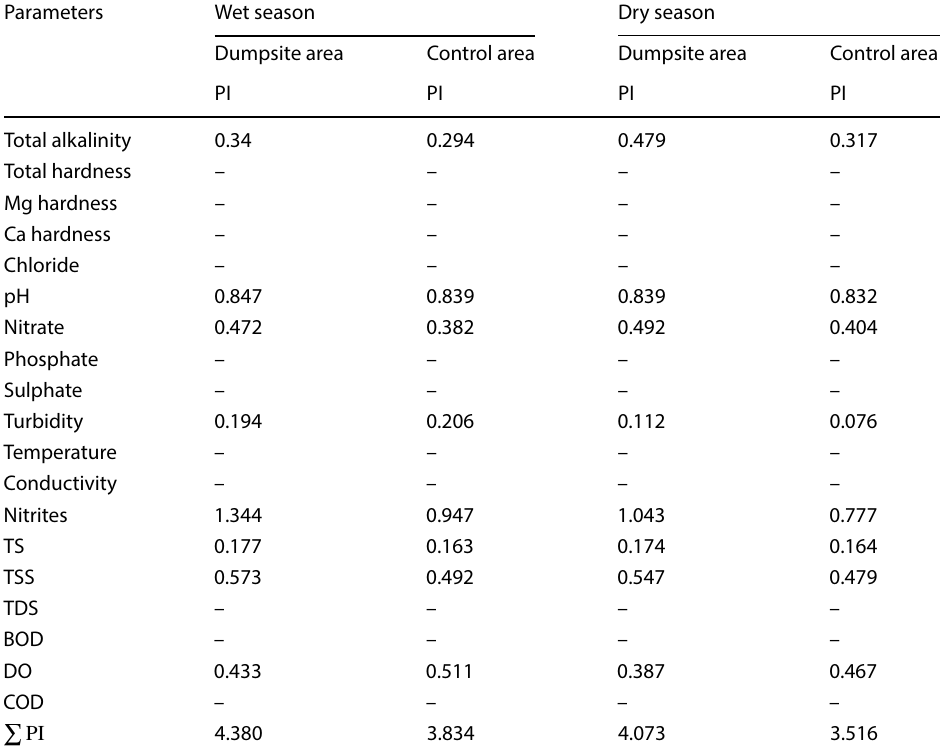
Table 3 Pollution index values of the borehole water samples